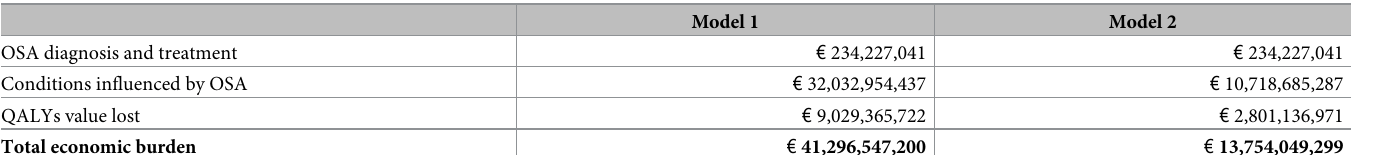
Table 5. Total annual economic burden of OSA in Italy.